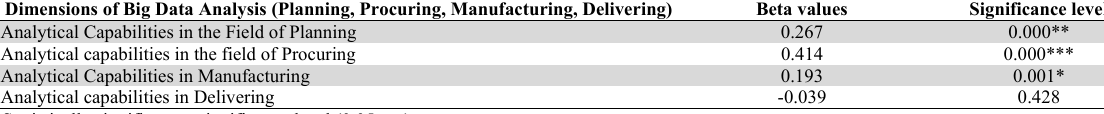
Indirect Impact of Process Orientation dimensions on Big Data Analysis Dimensions of Big Data Analysis (Planning, Procuring, Manufacturing, Delivering)